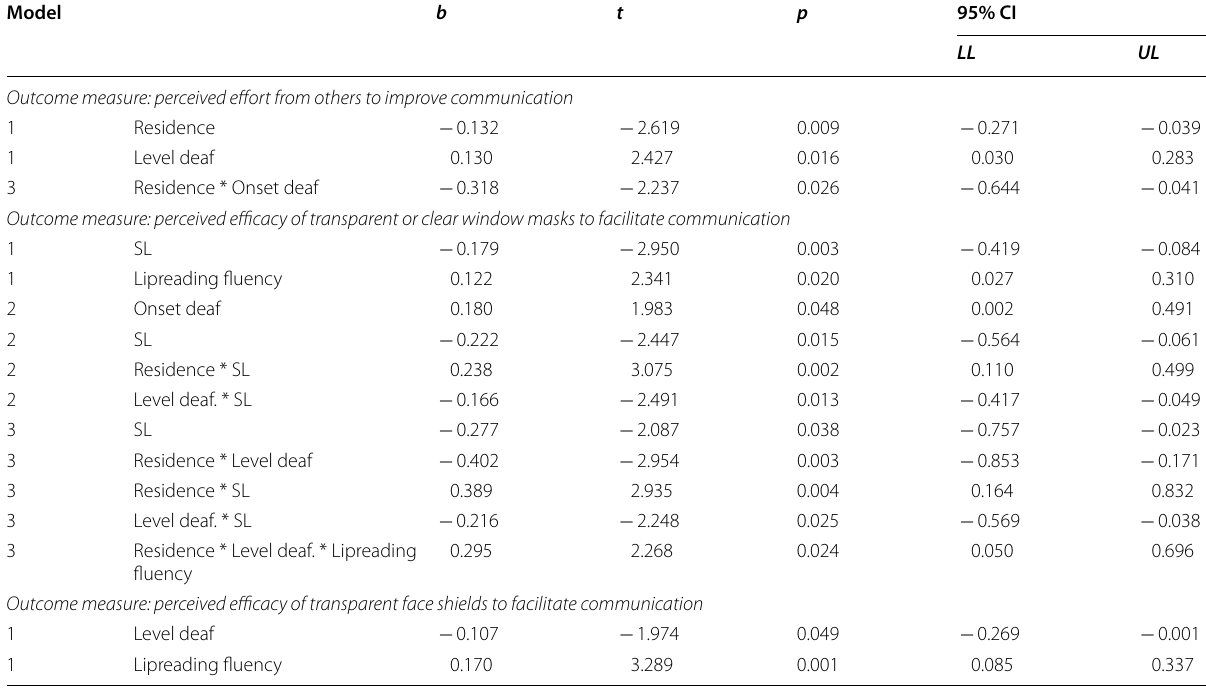
CI confidence interval; LL = deaf.: